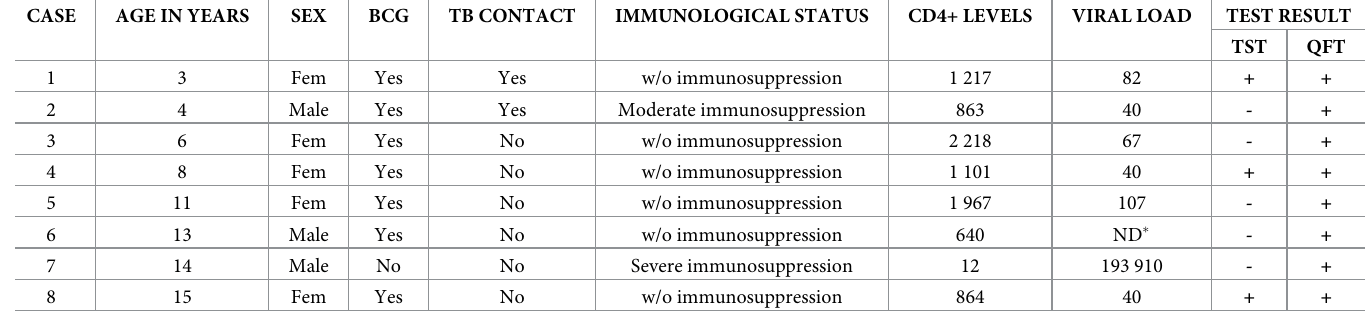
Table 3. Characteristics of patients with positive results to TST and/or QFT in the diagnosis of LTBI according to selected